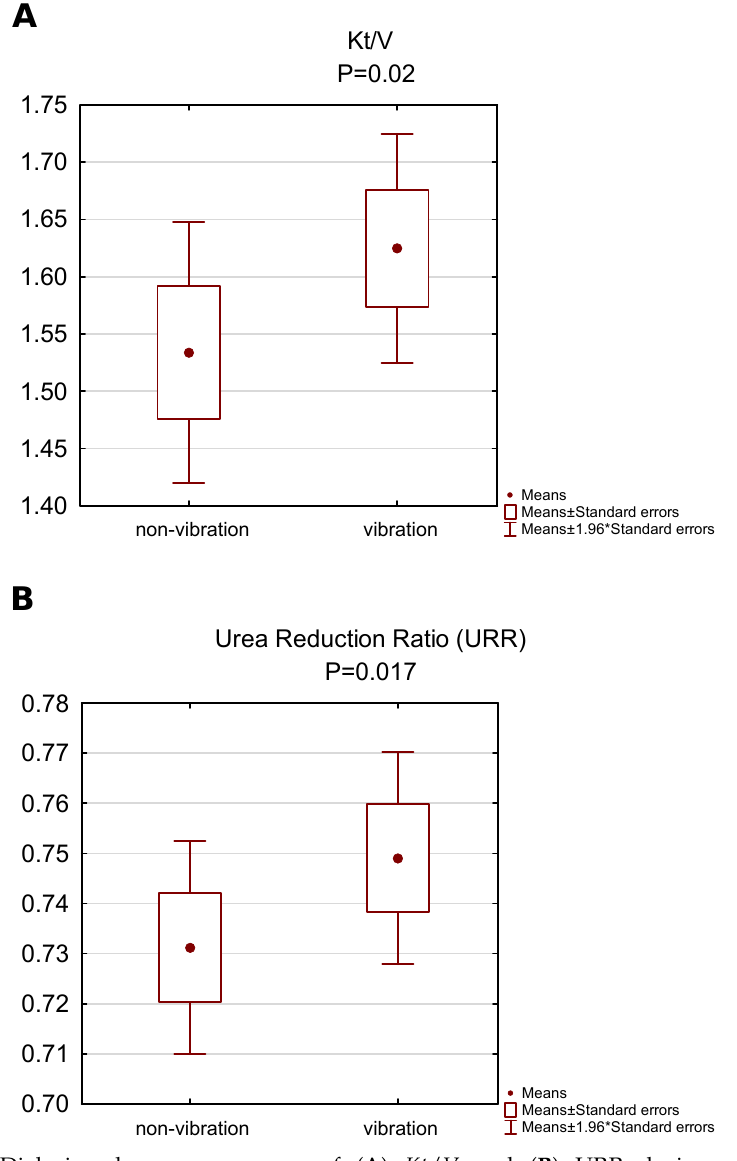
Figure 1. Dialysis adequacy measures of ( A ) Kt / V and ( B ) URR during non-vibration and vibration